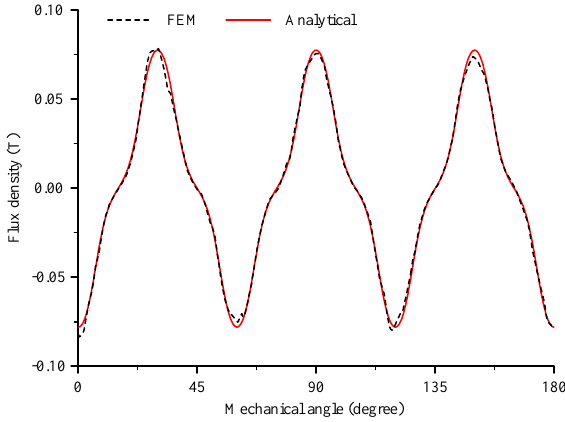
Figure 5. Flux density calculated by FEM and analytical model through the coils at the radius of 19 mm.